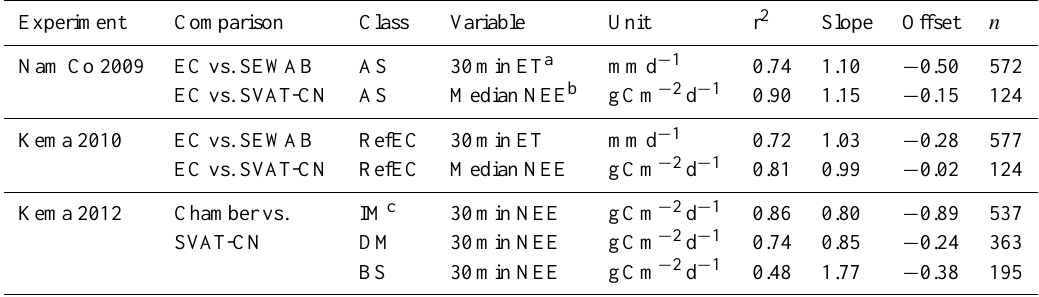
Table 7. Comparison of the models SEWAB and SVAT-CN against eddy-covariance and chamber measurements, using the squared Pearson correlation coefficient r 2 , as well as slope and offset of the linear regression; n is the number of